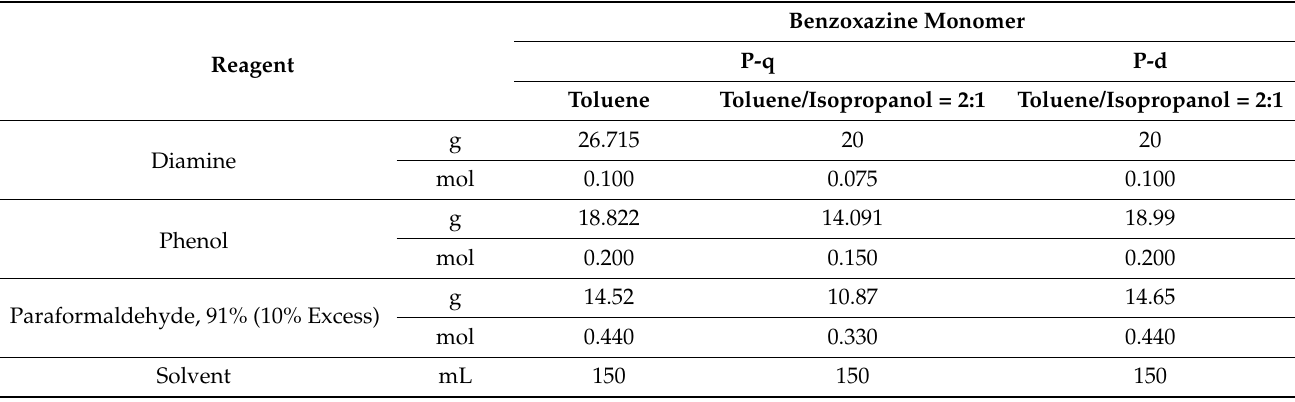
Table 1. The amounts of starting reagents for the synthesis of benzoxazine monomers based on diamines of various structures in various